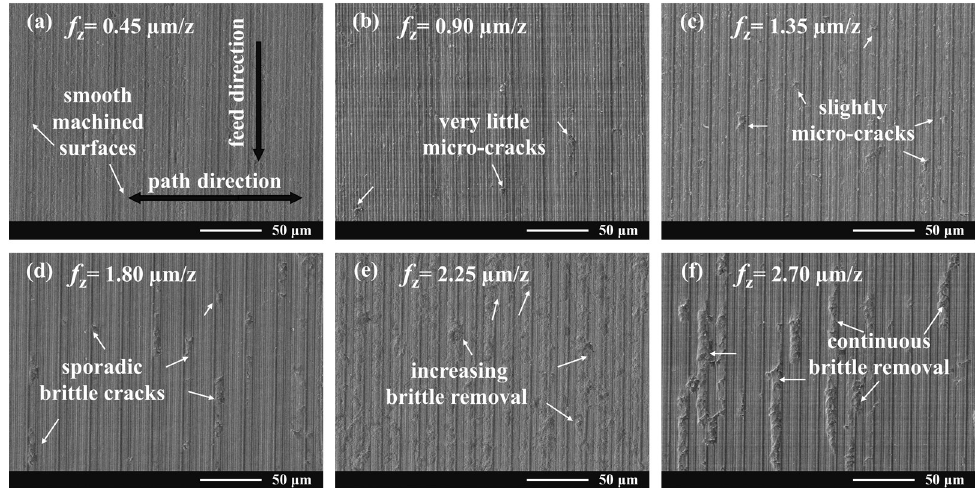
Figure 4. SEM images of micro-milled KDP surface at various feed rates per tooth.